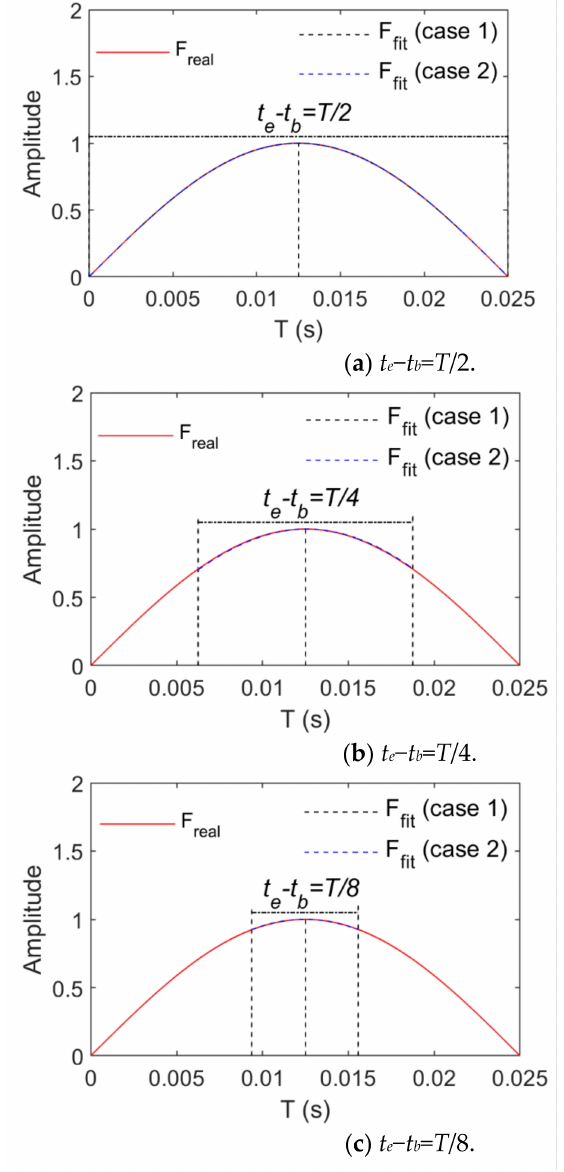
Figure 6. Comparison of real and fitting values of harmonic loads ( f = 20